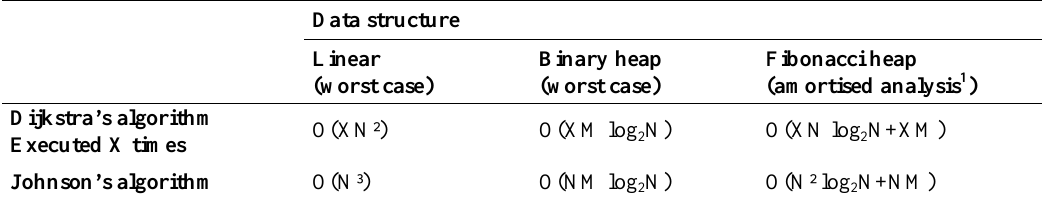
Table 4. Complexity of shortest-path